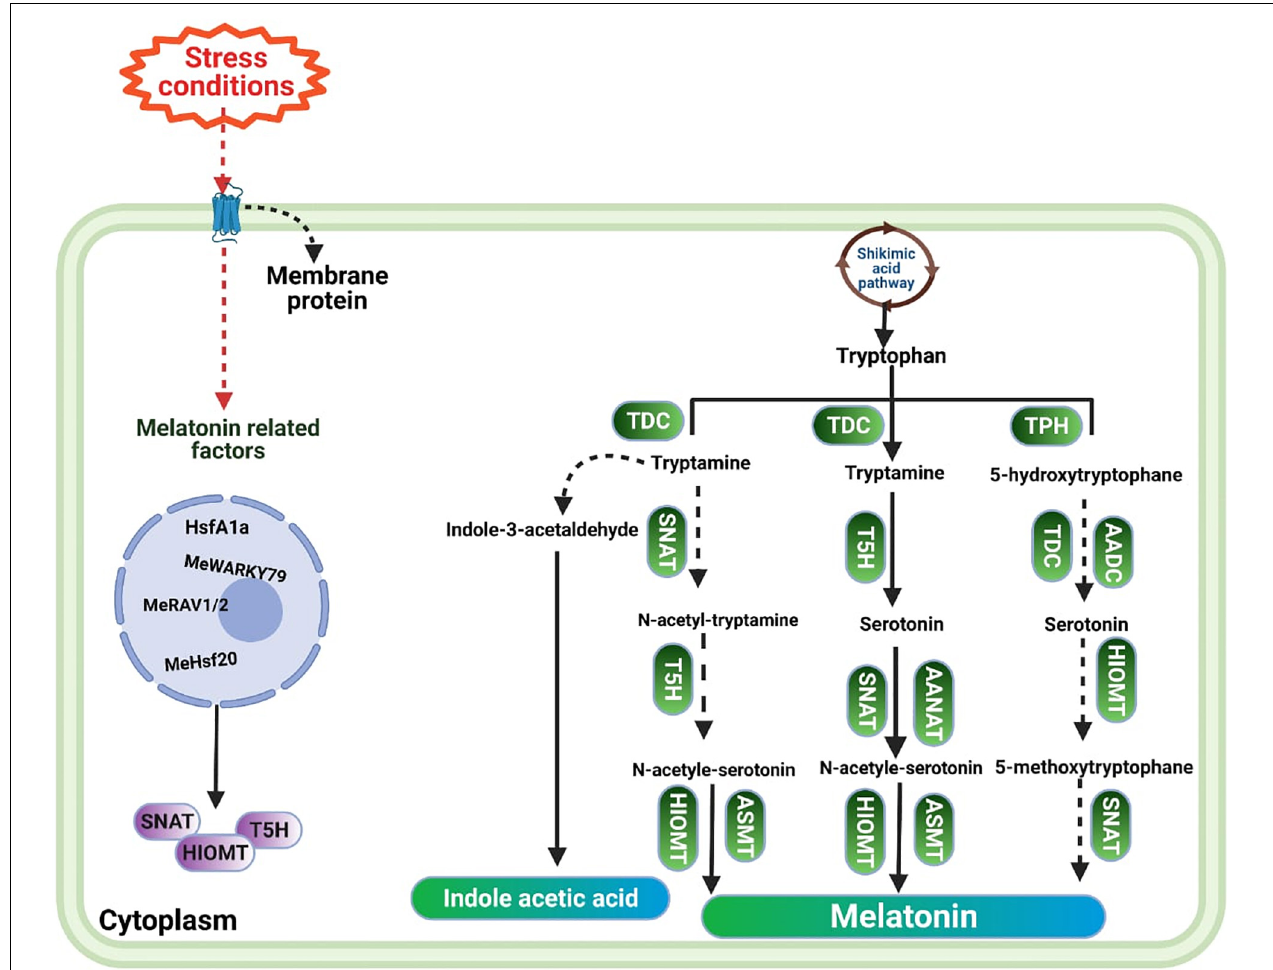
FIGURE 1 | The pathway of melatonin biosynthesis in